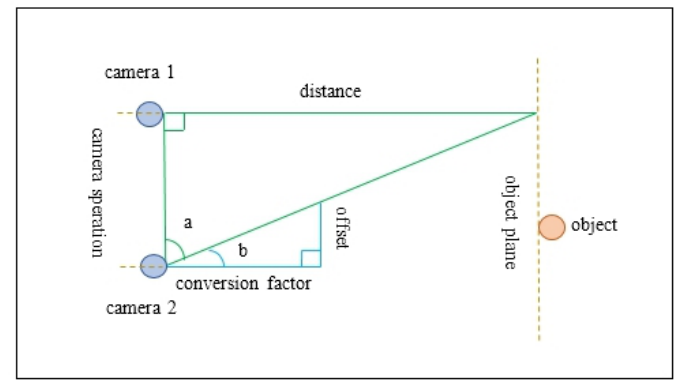
Figure 3. Stereo distance